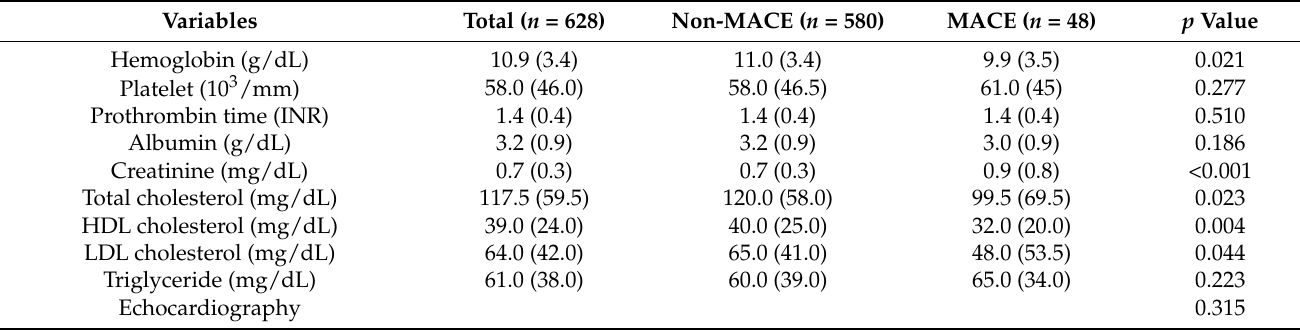
Table 2. Preoperative evaluation findings of liver transplant recipients according to the major adverse cardiac events that